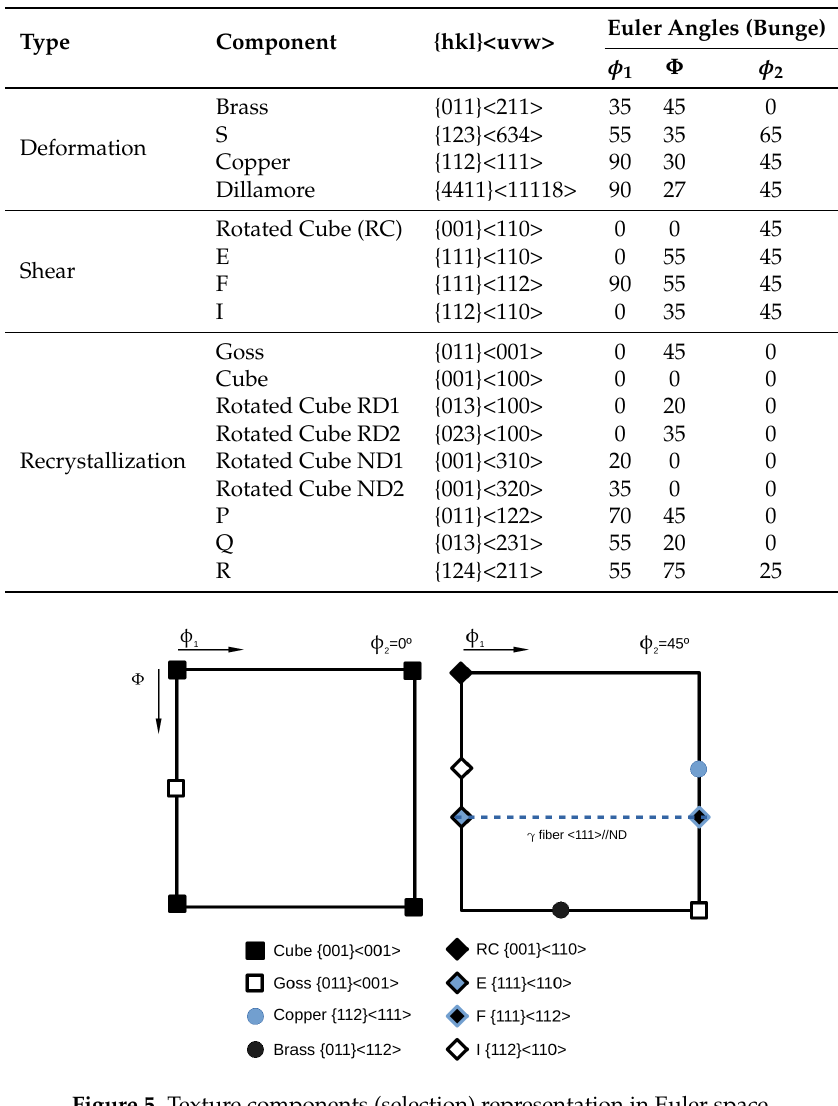
Table 1. Main texture components orientation in Euler space.